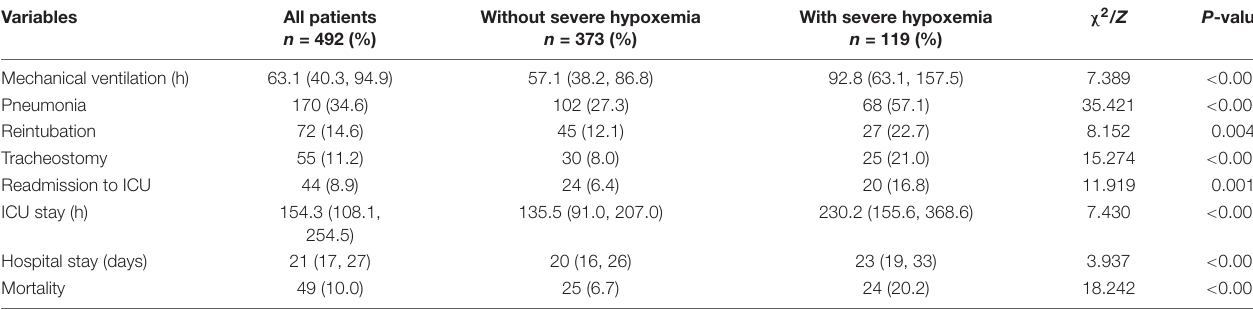
TABLE 4 | Clinical outcomes in patients with and without severe hypoxemia after AADS. Variables All patients Without severe hypoxemia n = 492 (%) n = 373 (%)